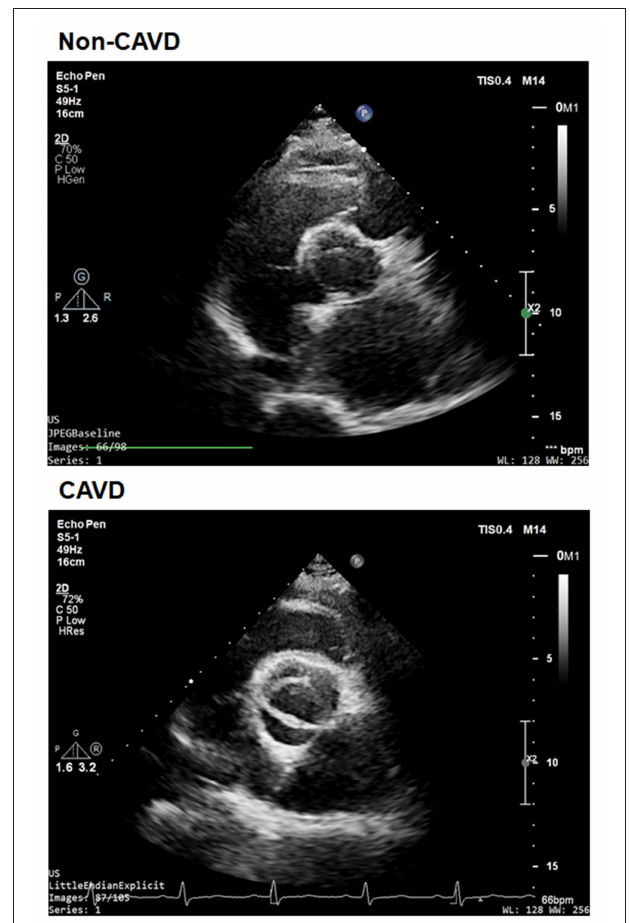
FIGURE 1 | A representative echo image of non-CAVD (upper) and CAVD (bottom).